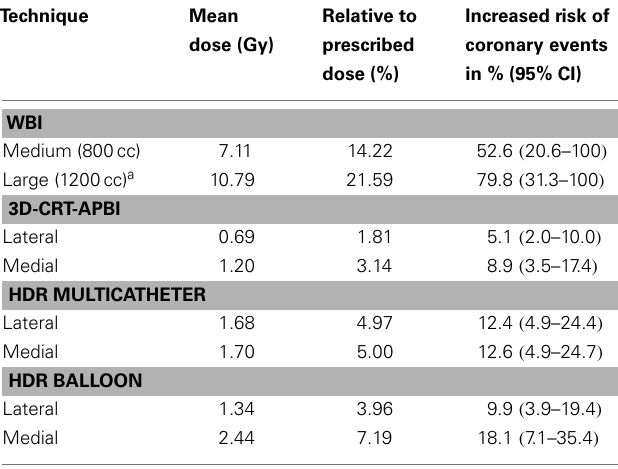
Table 2 | Set-up error and organ motion sensitivity analysis of the mean heart dose for the medium (800cc) and large breast phantom (1200cc) using a 1.5cm anterior heart shift